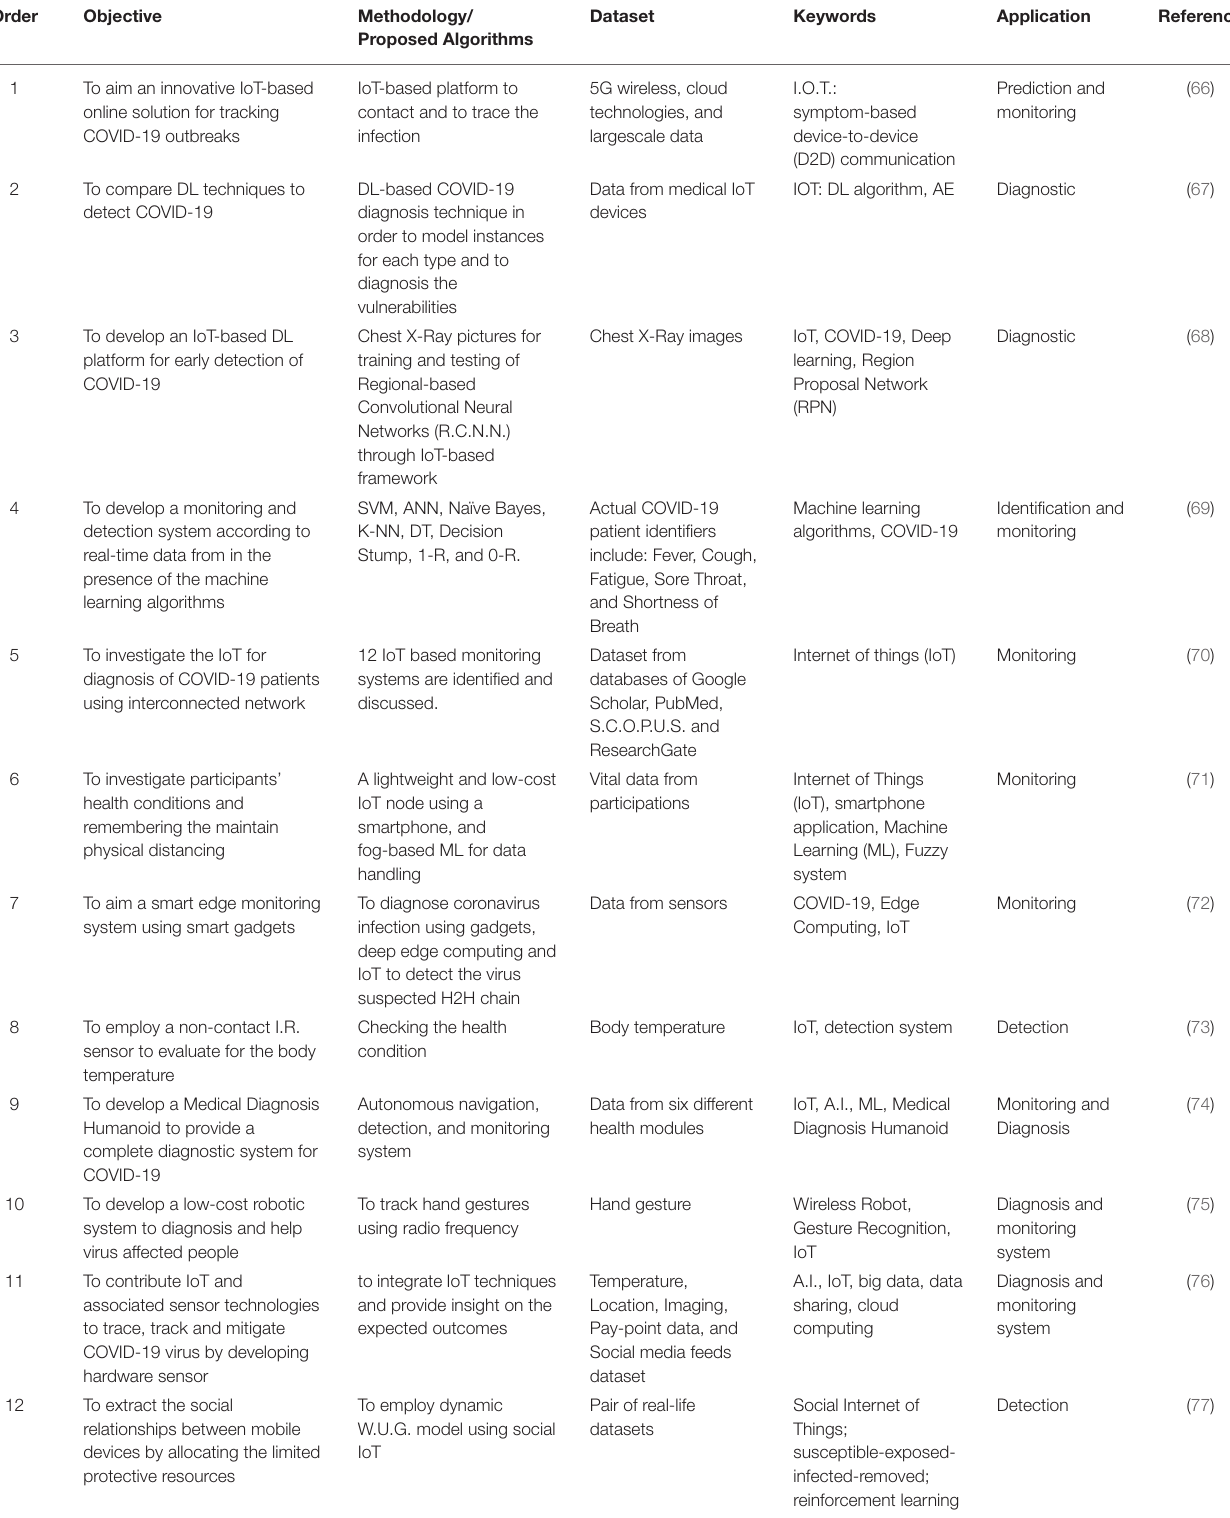
TABLE 2 | The main studies for the application of IoT based techniques for handling COVID-19.